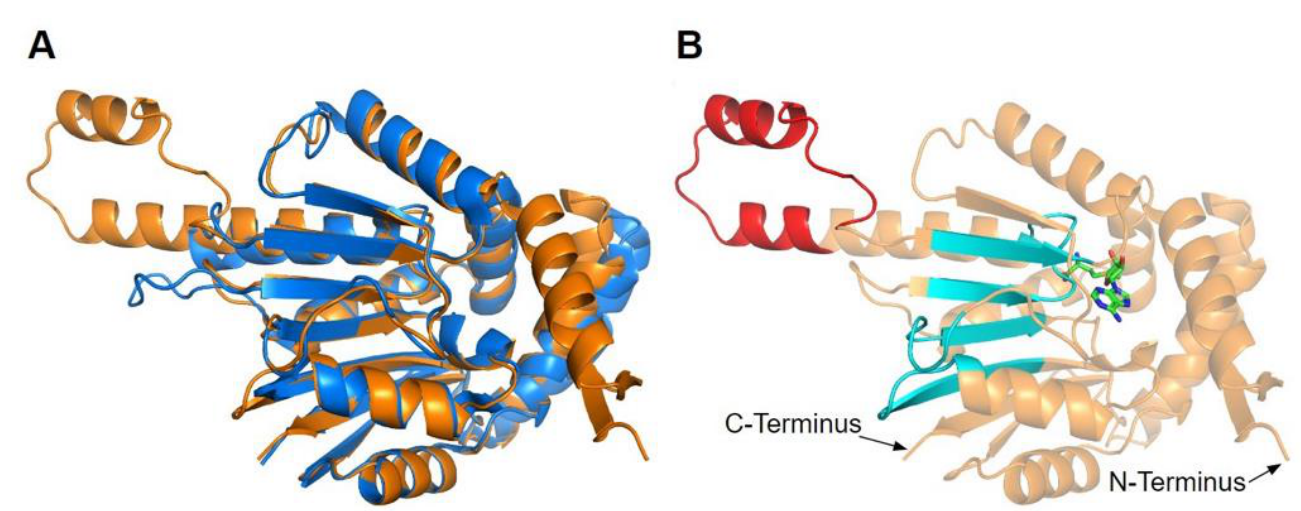
Figure 14. Alignment of AlphaFold-generated model of human COQ5 with existing yeast Coq5 crystal structures. ( A ) Superimposition of the human COQ5 model (shown in orange), adapted with permission from [39,54], and the crystal structure of AdoMet-bound yeast Coq5 (shown in blue, PDB: 4OBW). The first 47 residues of the AlphaFold model, which contains a disordered region with low confidence, were omitted for clarity. ( B ) Human COQ5 model with conserved methyltransferase motifs I-III and post-I highlighted in cyan and vertebrate insert in red. AdoMet (shown in green) was modeled via structural alignment with the crystal structure of AdoMet-bound yeast Coq5 using